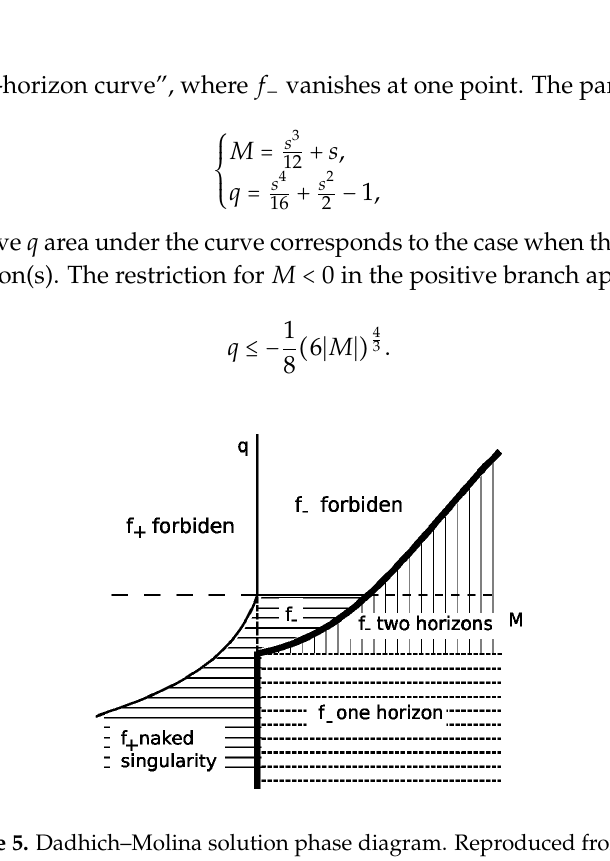
Figure 5. Dadhich–Molina solution phase diagram. Reproduced from